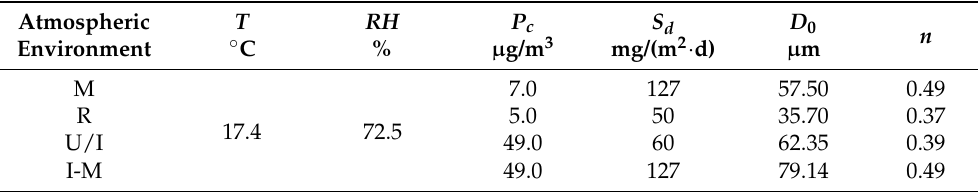
Table 1. Atmospheric data and D 0 and n values in the Ningbo